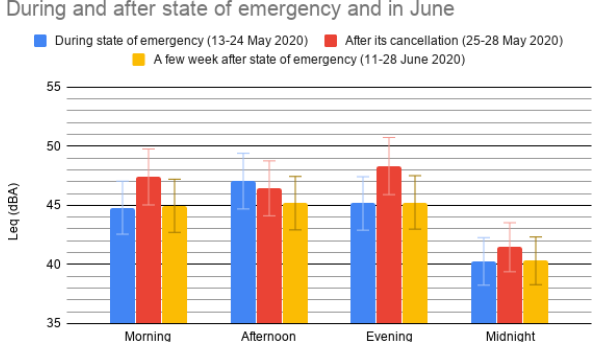
Figure 3: A comparison of the noise levels during the state of emer- gency, immediately after its cancellation, and in June. Error bars indicate the 95% ranges of each